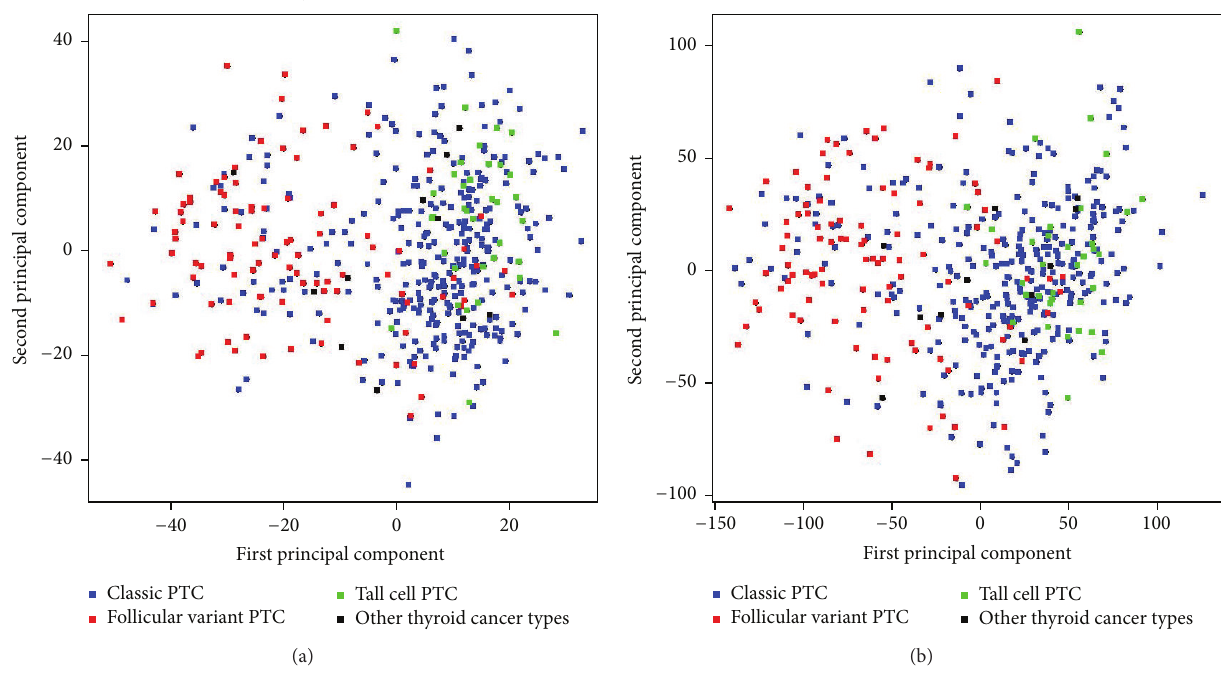
Figure 1: Principal Components Analysis of miRNA expression (a) and gene expression (b) data. fvPTC samples and tcPTC samples gather in 2 barely overlapping clusters (left and right parts of the plots, resp.). fvPTC and tcPTC difference represents the 1st principal component in both datasets; thus, it is the main source of miRNA and mRNA expression variability in the entire